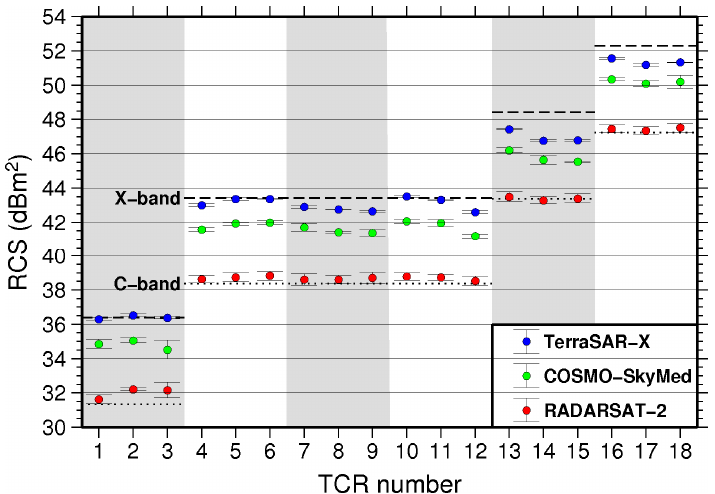
Figure 9. RCS measurements for each TCR at Gunning. RCS estimates are derived by averaging the values measured in 5 TSX images, 4 CSK images and 3 RSAT-2 images occurring during the period of relatively stable clutter (Figure 8). Error bars are the 2-sigma standard errors of these observations. Theoretical RCS values (Equation (6)) for each TCR size are plotted as dashed lines (X-band) and dotted lines (C-band). Background grey polygons are plotted to aid delineation of the different type groups of TCR design described in Table 2.